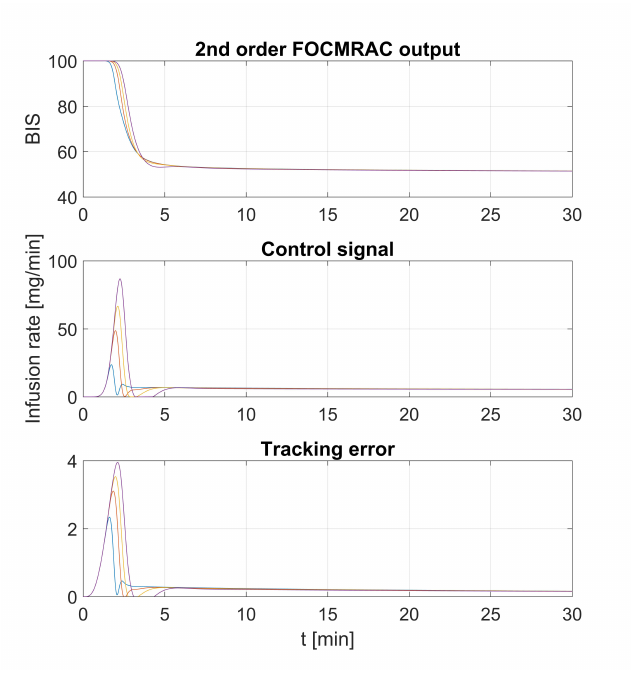
Figure 23. BIS response of patient 1 with different time delays using the 2nd-order FOCMRAC scheme.